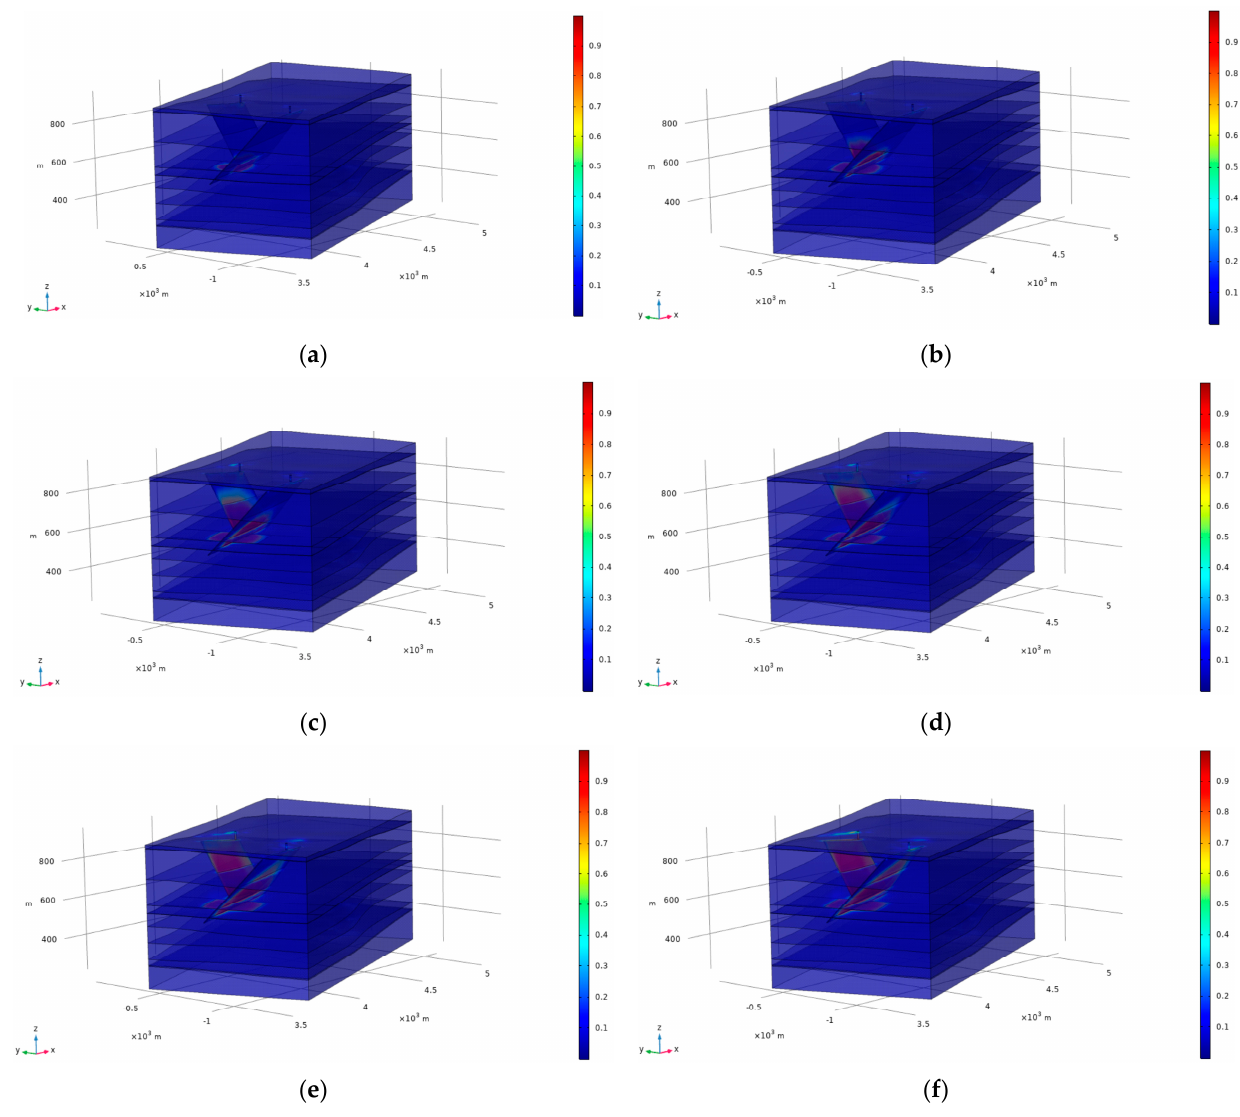
Figure 14. Slurry transport clouds at different times: ( a ) 1d; ( b ) 3d; ( c ) 5d; ( d ) 7d; ( e ) 10d; ( f ) 13d .